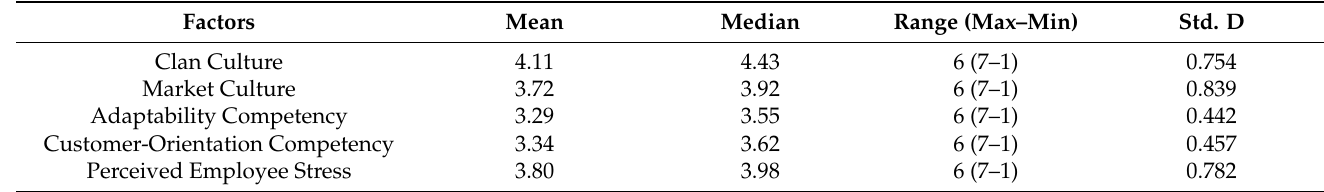
Table 5. Descriptive Statistics for Final